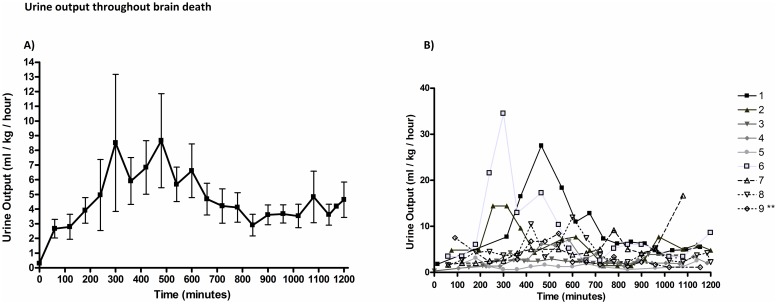
Urine output throughout brain death.Although there was variability among animals (Fig 6B), the average peak UO occurred 5–8 hour after BD induction (Fig 6A). All but one animal exceeded the 4ml/kg/hr of urine output at some time point in the experiment.